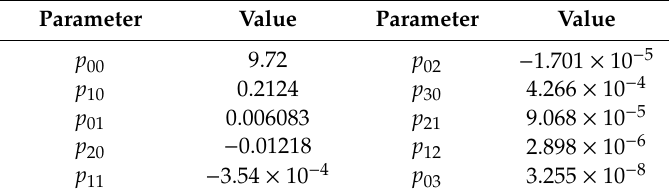
Table 3. Controlling parameters of the polynomial function for k 0 .